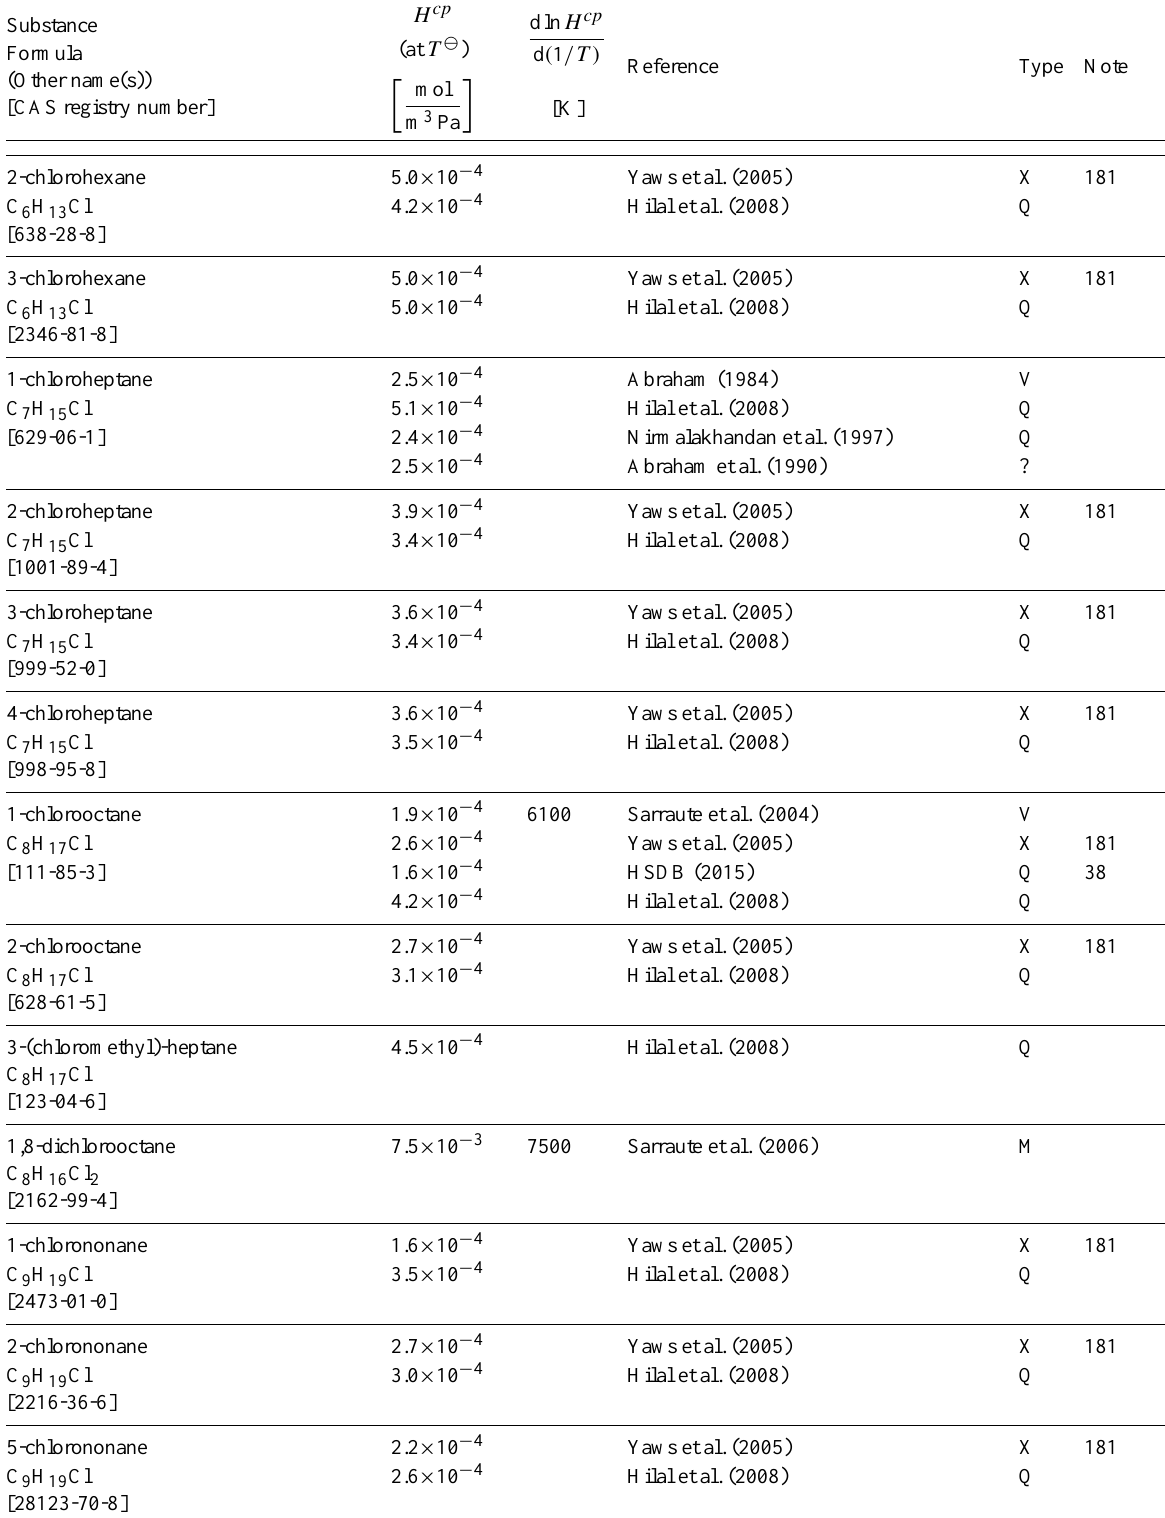
Table 6: Henry’s law constants for water as solvent